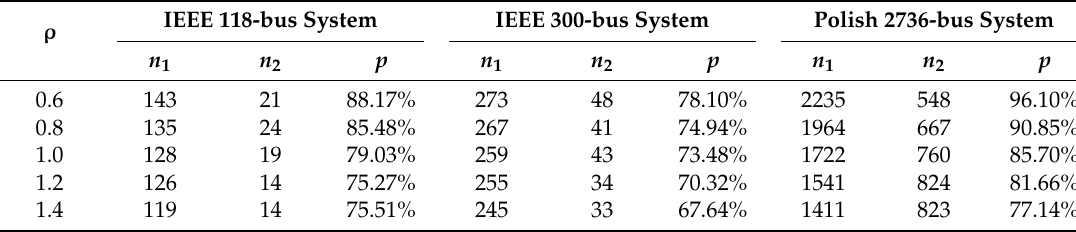
Table 3. Impact of the primary and secondary filtering